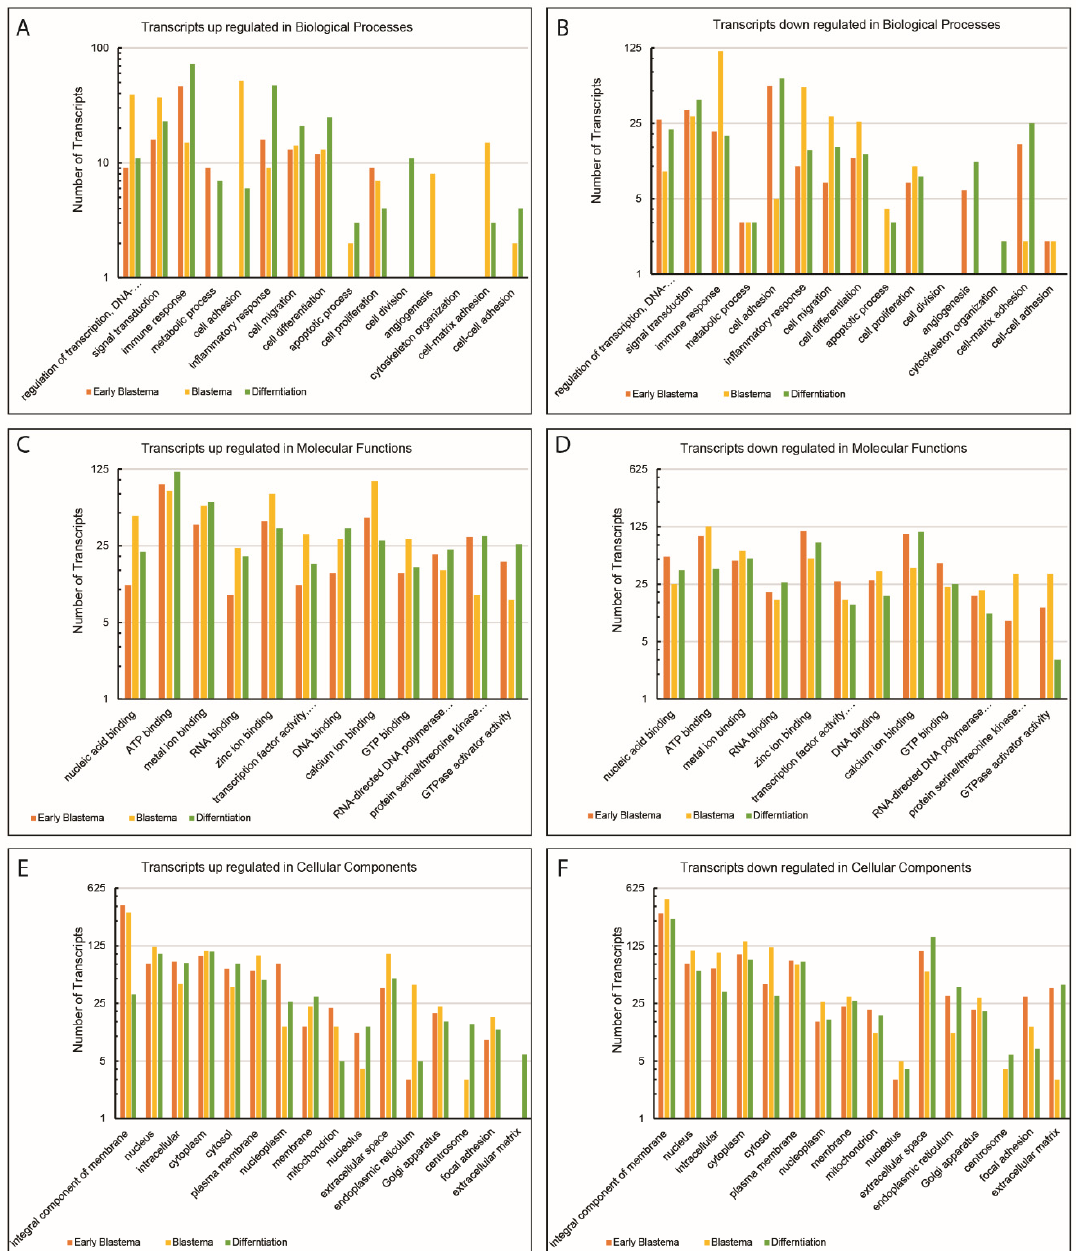
Figure 5. Histogram representation of the gene ontology classification of up- and down-regulated transcripts from early blastema (EBL), blastema (BL) and differentiation (DF) stages with respect to the normal tail during regeneration in H. flaviviridis. ( A , B ) Up-regulated and down-regulated transcripts in biological processes; ( C , D ) Up-regulated and down-regulated transcripts in molecular processes; ( E , F ) Up-regulated and down-regulated transcripts in cellular processes. Table 2. Count of differentially expressed transcripts.